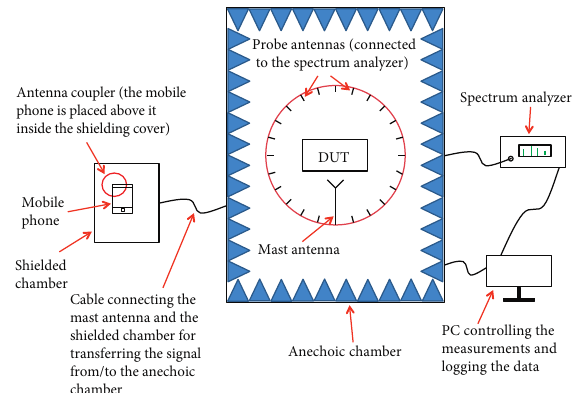
Figure 3: Overview diagram of the measurement system. DUT is acronym for the device under